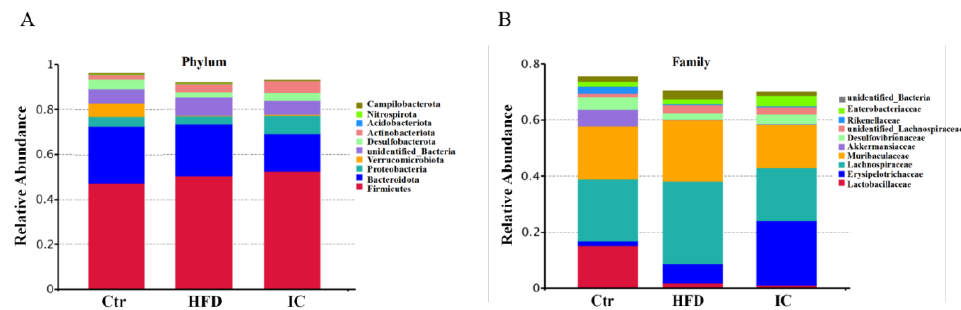
Figure 4. Gut microbiota compositions at the phylum ( A ) and family ( B ) levels for the three experi- mental groups.